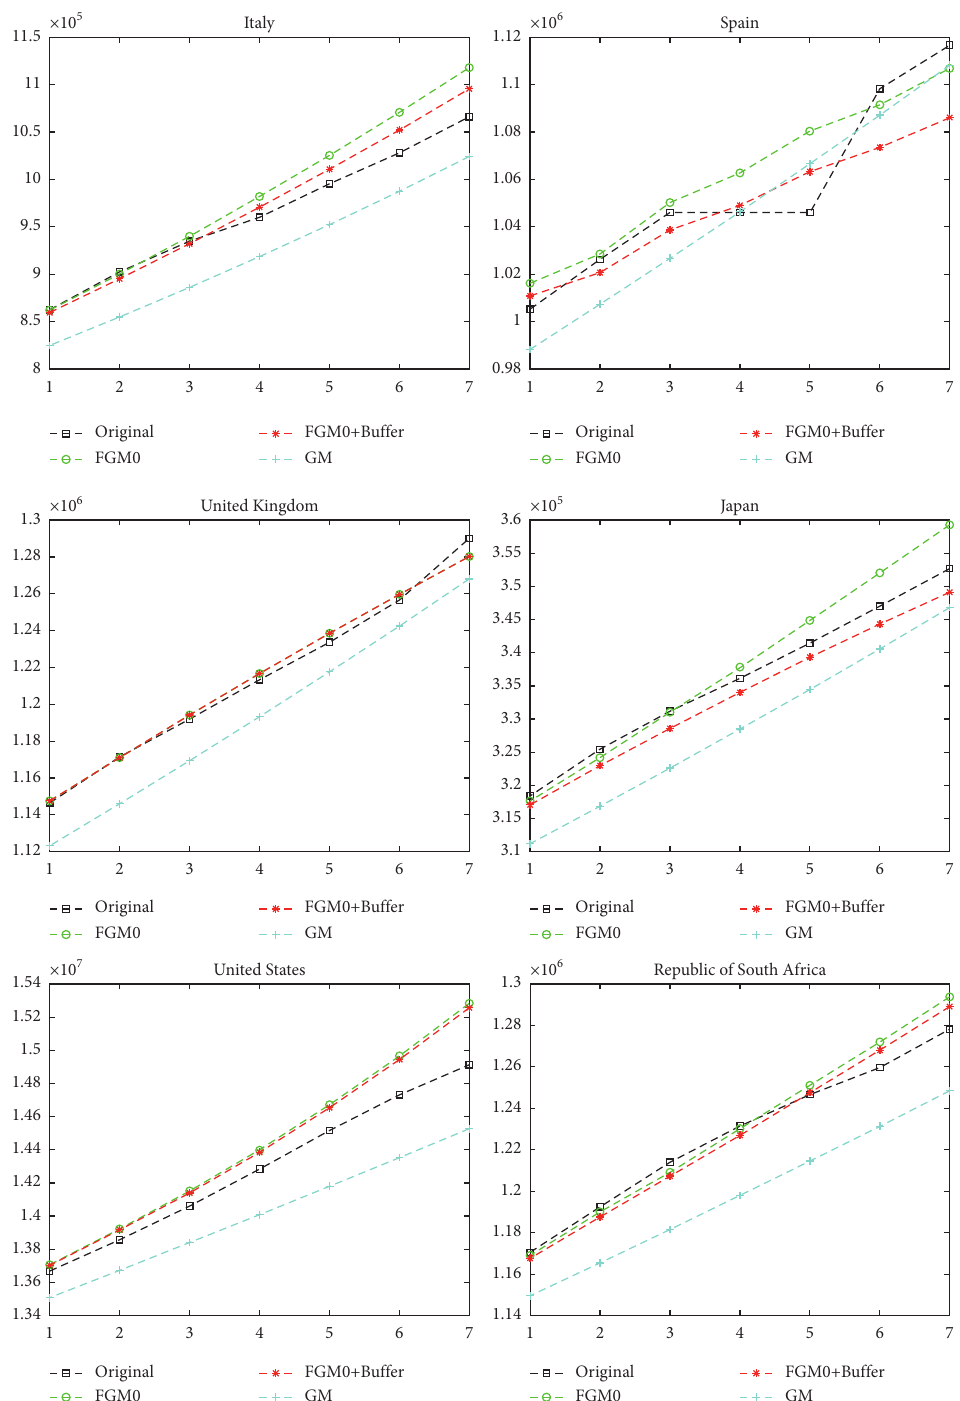
Figure 10: The prediction performance after the government’s control measures took effect in the second outbreak of